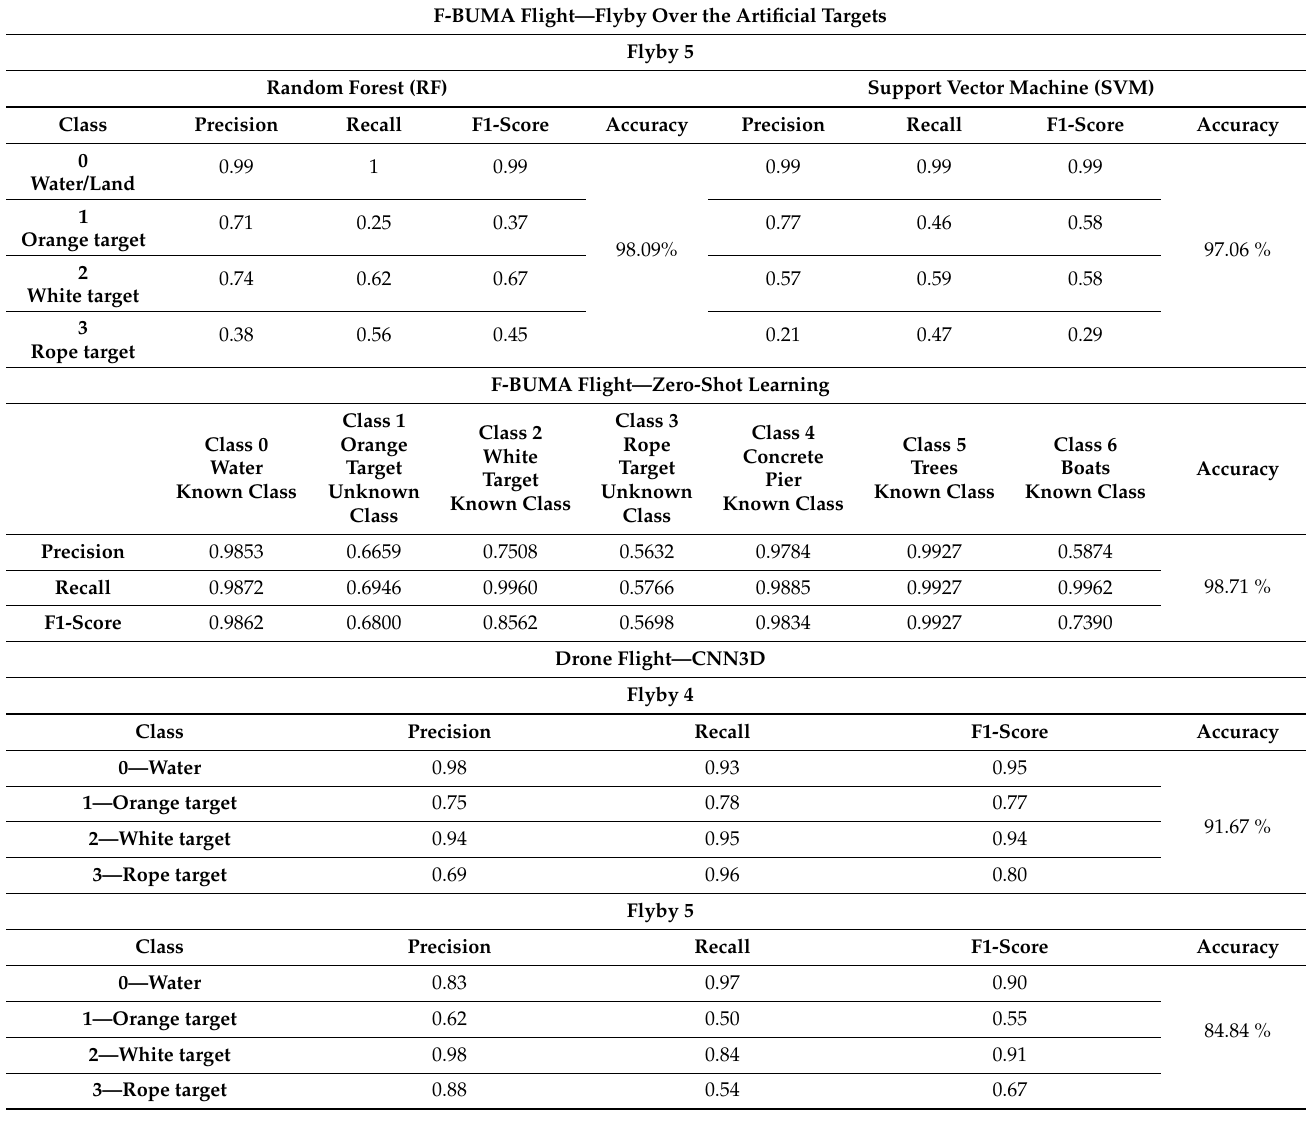
Table 3. Results comparison using RF, SVM, CNN and ZSL